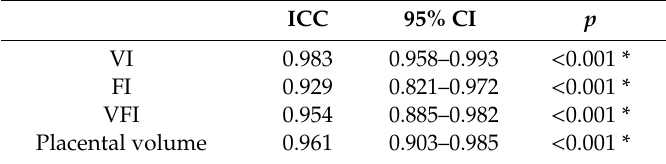
Table 3. Intraclass correlation coe ffi cients of placental vascular indices and placental